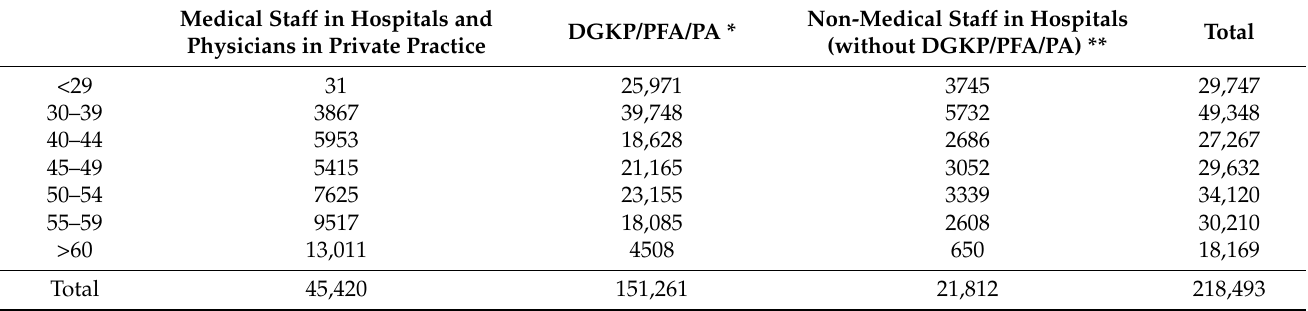
Table A2. Number of healthcare workers by age groups [43].